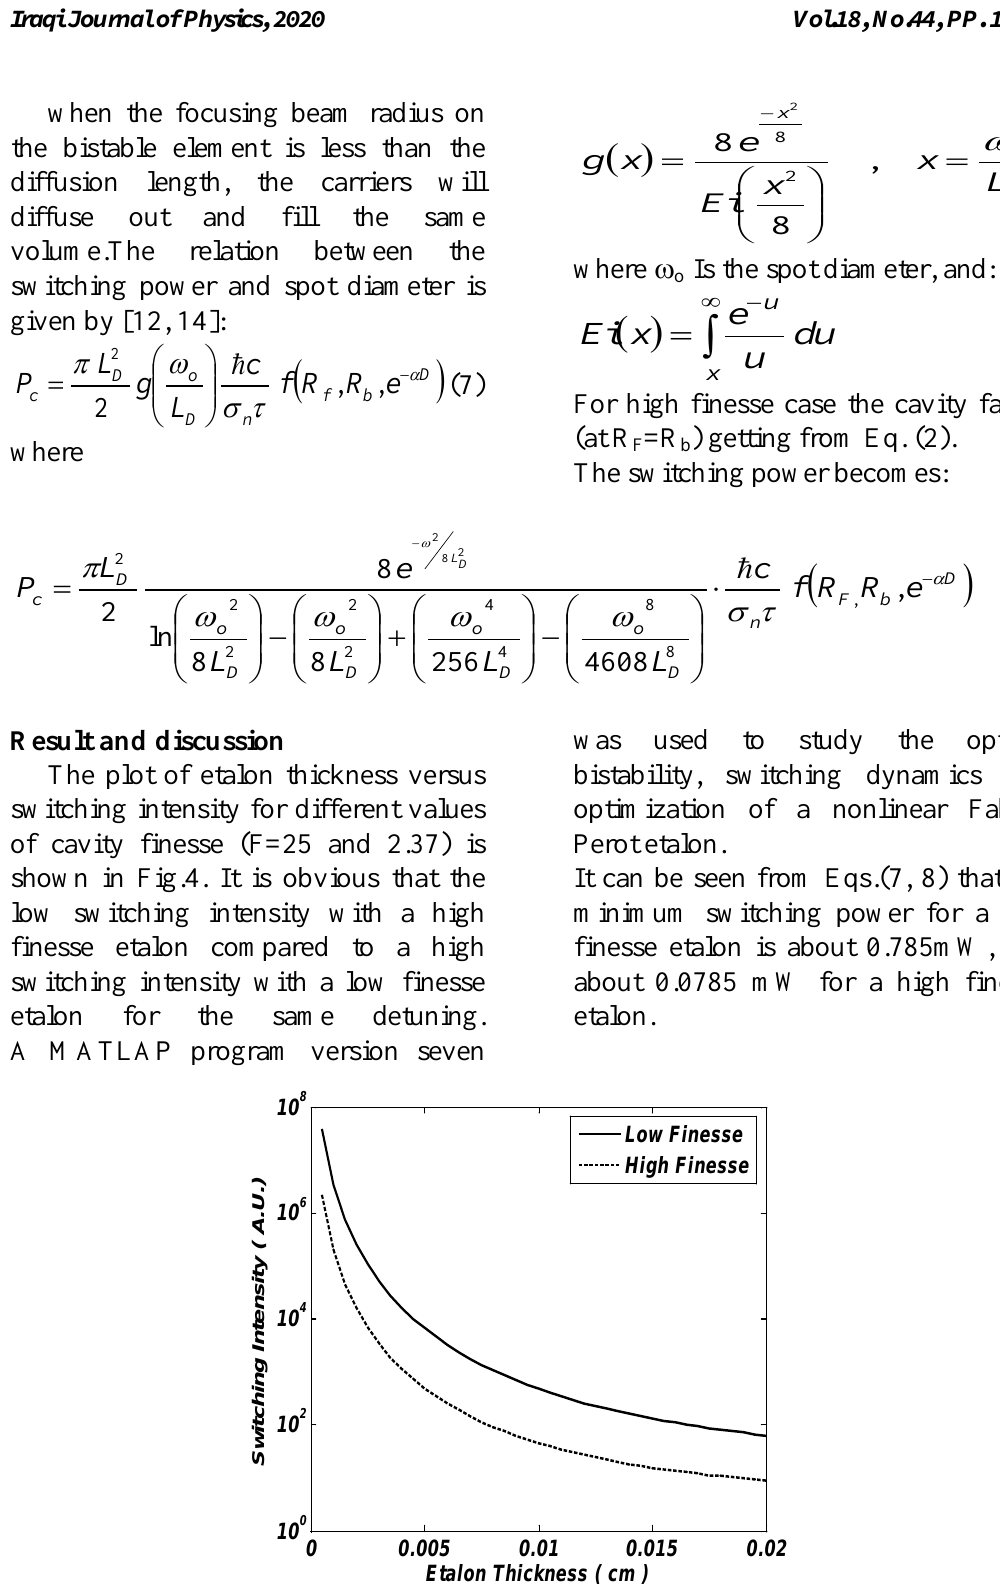
Fig.4: The effect of the etalon thickness on the switching intensity for different values of cavity